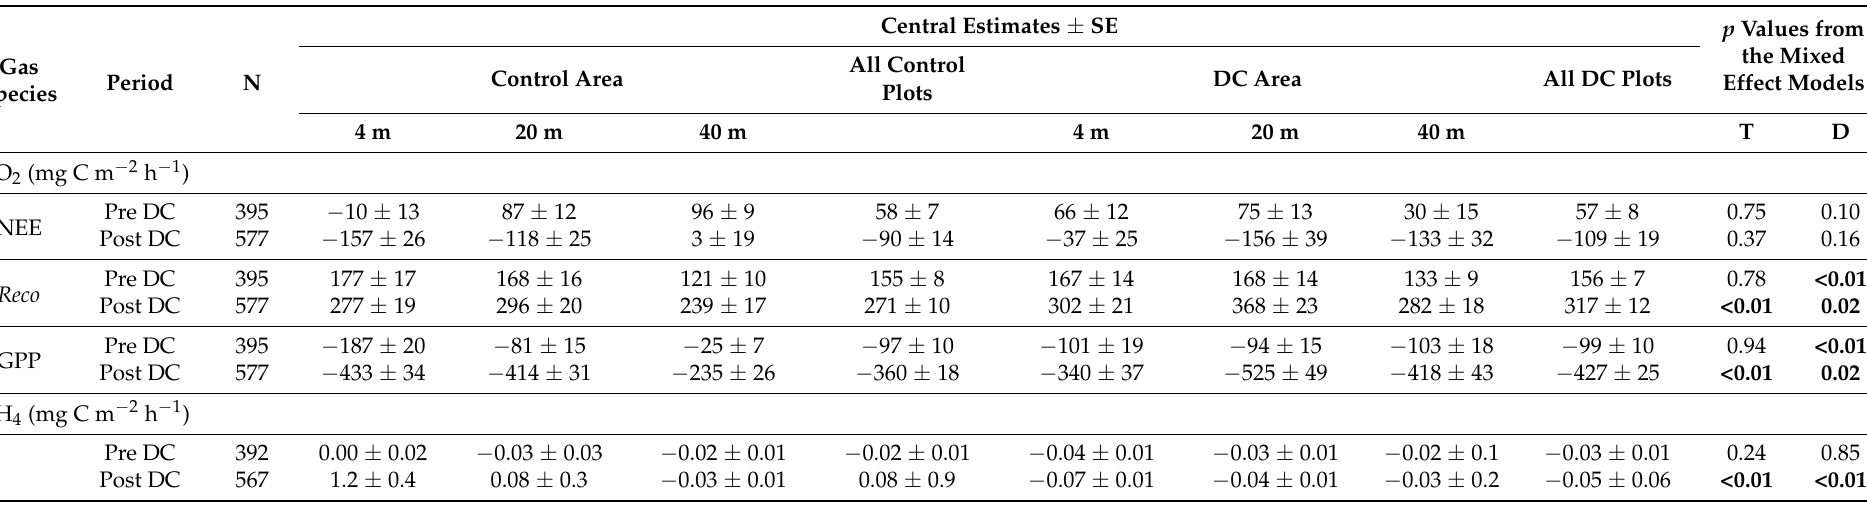
Table 2. Annual central estimates ± standard error (SE) and mixed effect model results for ditch treatment effects (control versus DC) and distance to ditch combinations (4 m, 20 m and 40 m) on CO 2 and CH 4 fluxes based on observations during pre-DC (2018/19) and post-DC periods (2020/21). Mean and median values were applied for the central estimates of CO 2 and CH 4 flux values, respectively. Fixed factors of mixed effect models include ditch cleaning treatment